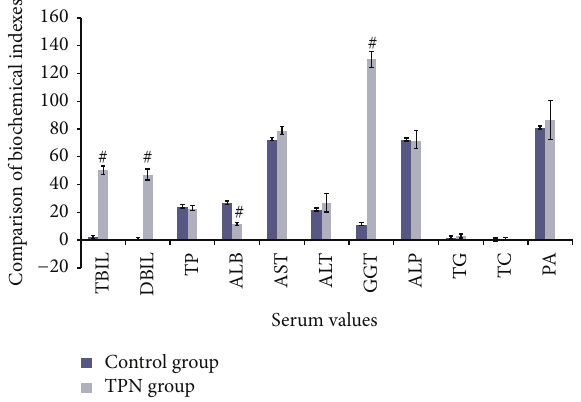
Figure 1: A comparison of serum biochemical data from the TPN and control groups. Note: each value is the mean ± SD of assays using 8 independent samples. Compared with the control group, # 𝑃 < 0.01 . TBIL: total bilirubin, DBIL: direct